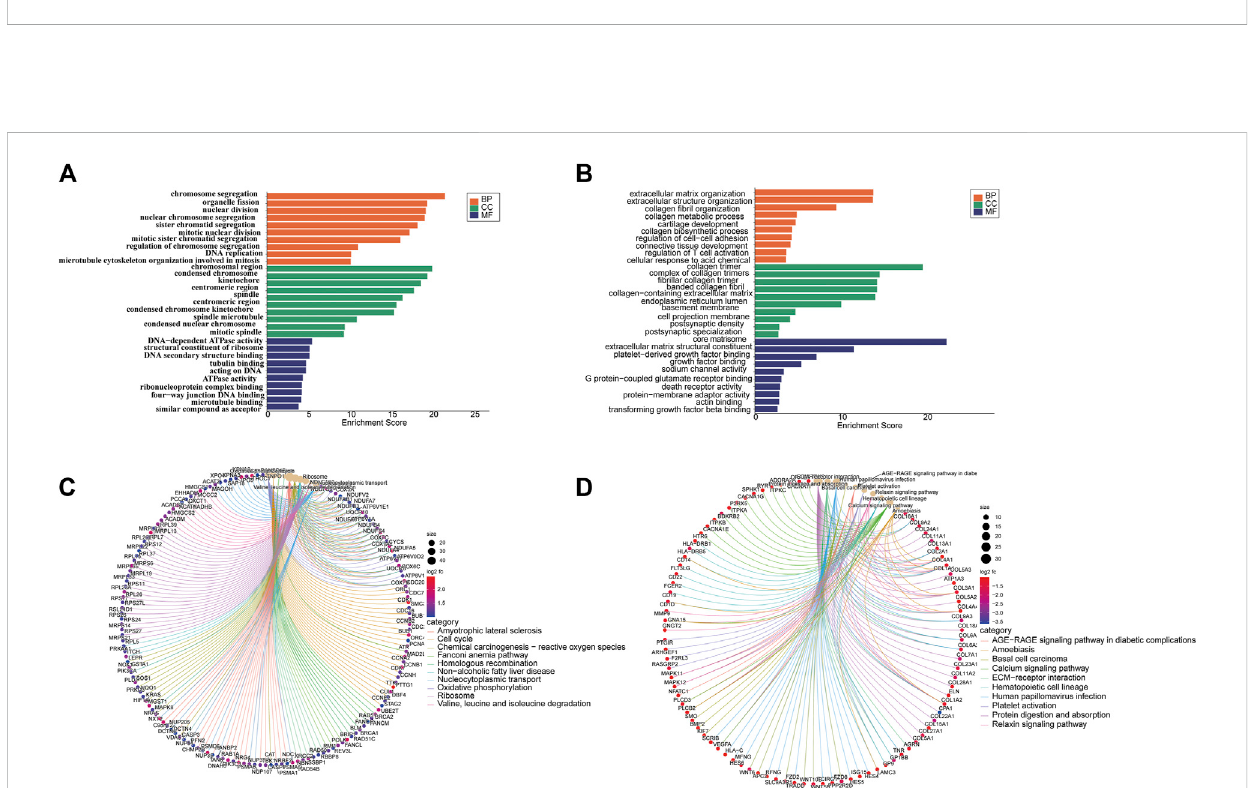
FIGURE 4 TheGOanalysisandKEGGpathwayenrichmentoftargetmRNAsofdifferentialmiRNAs. (A) Thetop fi veenrichmentsfromGoterms(BP/CC/MF)for the target mRNAs of upregulated miRNAs. (B) The top fi ve enrichments from Go terms (BP/CC/MF) for the target mRNAs of downregulated miRNAs. (C) Thetop10pathwaysenrichedfromKEGGoftargetmRNAsofupregulatedmiRNAs. (D) Thetop10pathwaysenrichedfromKEGGofthetargetmRNAsof downregulated miRNAs ( p < 0.05). Coloring indicates the p -value with higher values inred and lower values in blue, and thelower p -value indicates that the gene is more signi fi cantly enriched. (GO, gene ontology; KEGG, kyoto encyclopedia of genes and genomes; BP, biological processes; MF, molecular function; CC, cellular